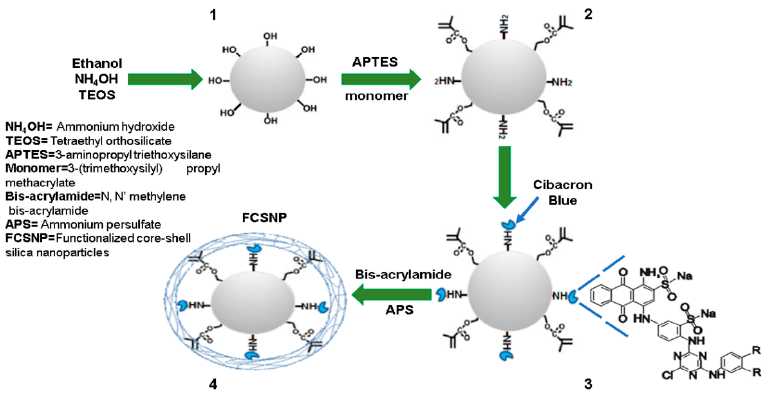
Figure 1. Schematic illustration of the strategy used for the synthesis of functionalized core-shell silica nanoparticles (FCSNP).